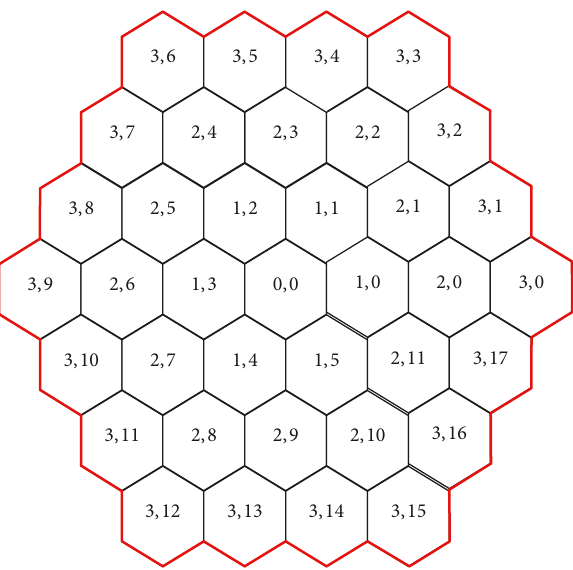
Figure 4: Cells addressing in the honeycomb